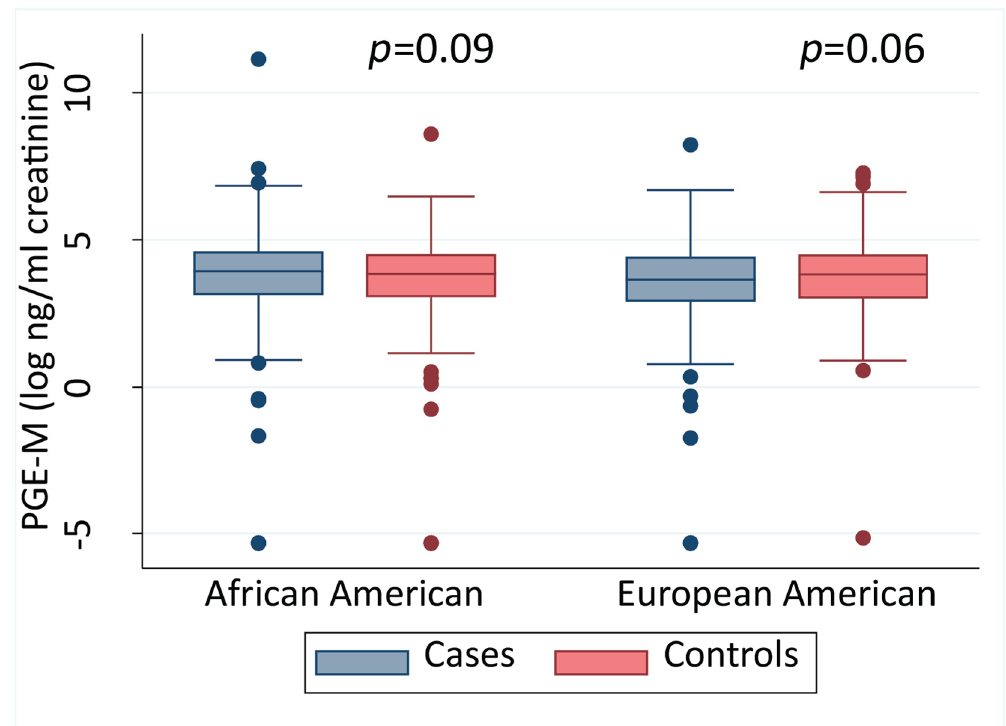
Figure 1. Urinary PGE-M levels in African American and European American men. Urinary PGE-M levels in cases and controls stratified into African American and European American men shown as a continuous measure, stratified by race. A two-sided Mann–Whitney test was applied for statistical significance testing. The error bars represent the 95% CI.